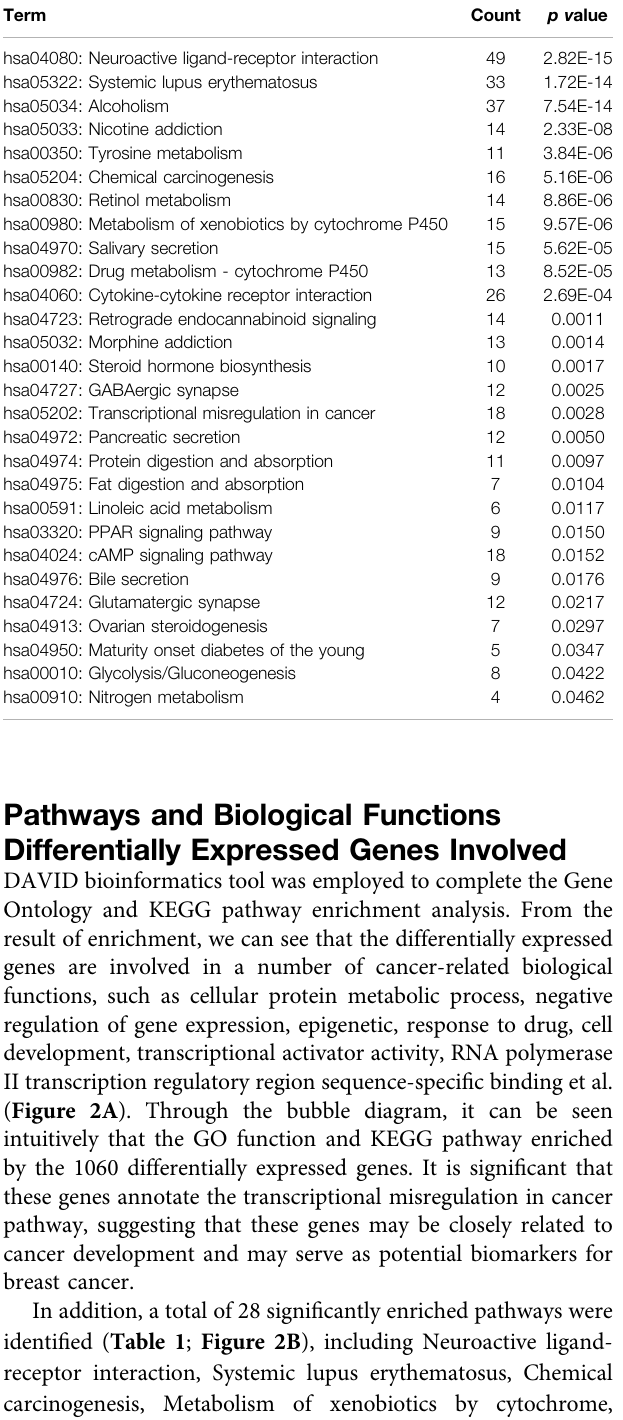
FIGURE 3 | KEGG pathways network of gene-gene interaction. (A) KEGG pathways network, which contains 1277 nodes and 7345 edges, and the size of the nodes is represented by the degree. (B) Probability density distribution of nodes degree in the network, which conforms to the power law